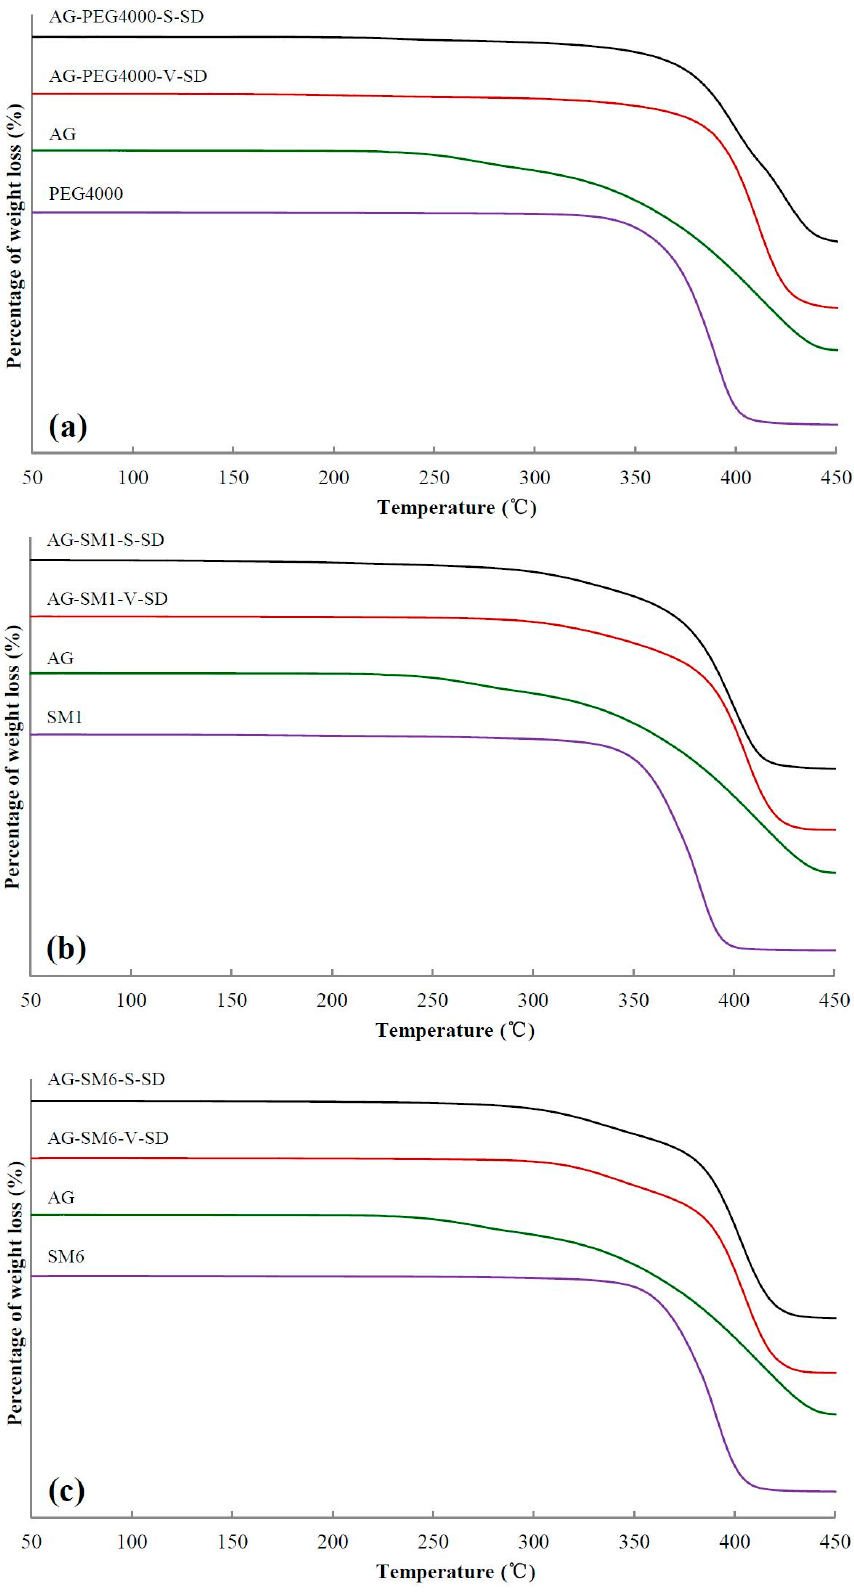
Figure 3. Thermogravimetric (TG) curves of pure andrographolide (AG), carrier materials, physical mixtures (PM), and solid dispersions (SD): ( a ) PEG4000 as carrier material, ( b ) SM1 as carrier material, ( c ) SM6 as carrier material. Table 2. T i (5% weight-loss temperature) and T m (melting temperature) of pure andrographolide (AG), physical mixture (PM), and solid dispersion (SD).